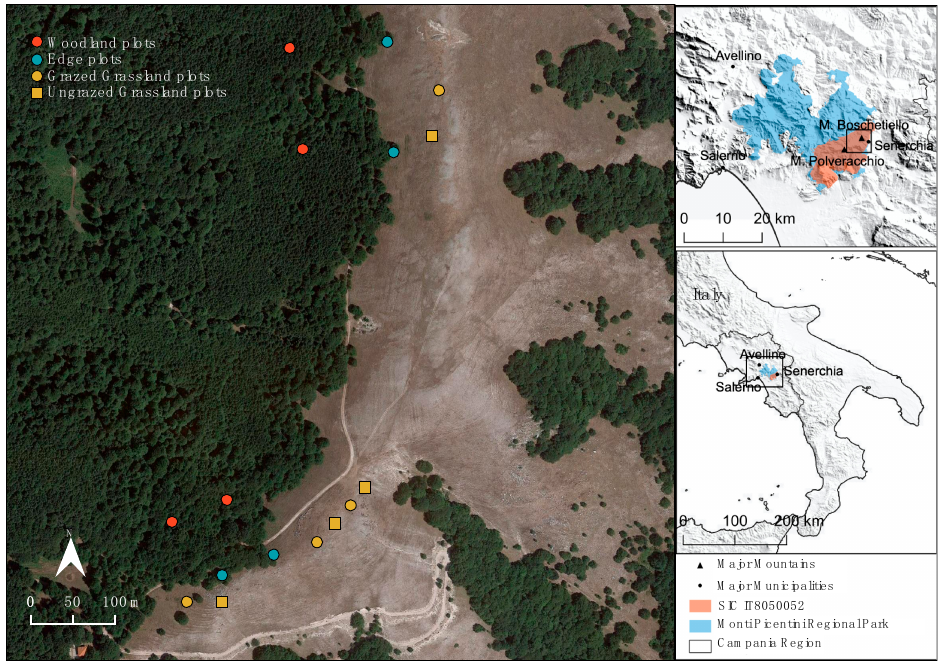
Figure 1. Study area and its location in Southern Italy. The satellite image shows the pasture on Mount Boschetiello where this study was carried out, along with the location of sampling plots (in red circles, woodland plots; in turquoise circles, edge plots; in orange circles, grazed grassland plots; and in orange squares, ungrazed grassland plots). Satellite image attributed to Image ©2019 Google.